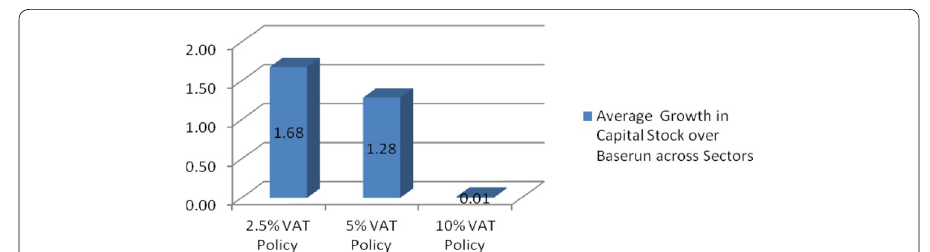
Fig. 27 Average growth in capital stock over base run across sectors